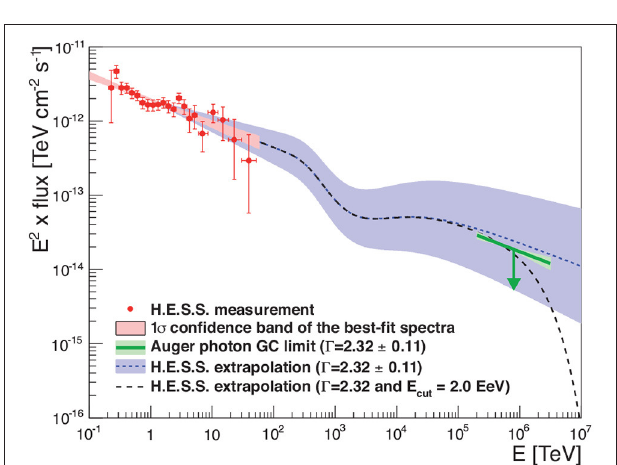
FIGURE 6 | Gamma-ray spectrum from the Galactic center region as measured by the H.E.S.S. collaboration (red points) (Abramowski et al., 2016). The measured photon flux is extrapolated into the EeV range, given the quoted spectral index and its uncertainties (blue shaded region). The Auger limit (Aab et al., 2017a) is indicated by a green line (the green band reflects again the spectral uncertainties of the gamma-ray spectrum). A spectral index with cutoff energy E cut = 2.0 · 10 6 TeV is indicated by the dashed